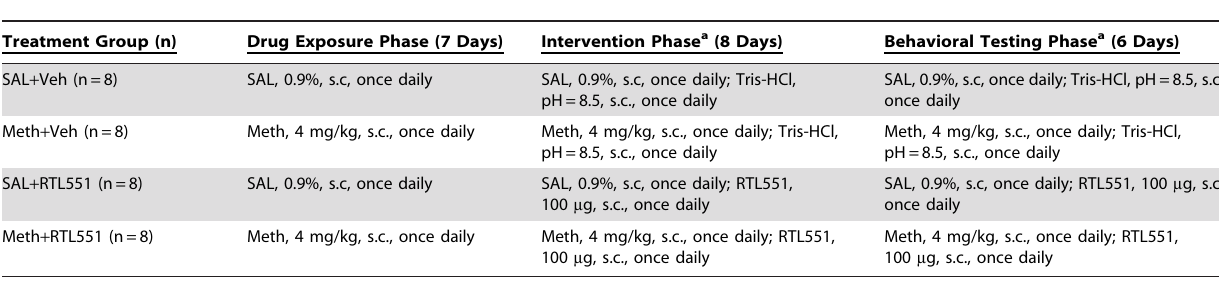
Table 1. Study Design: Investigation of repeated methamphetamine exposure and RTL treatment on cognitive function.